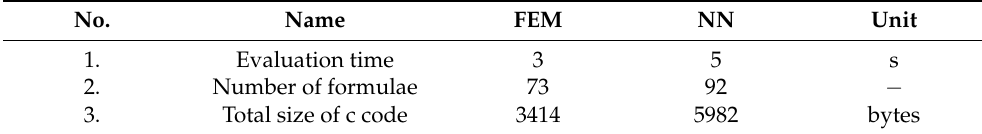
Table 2. AceGen—FEM vs. NN formulations.